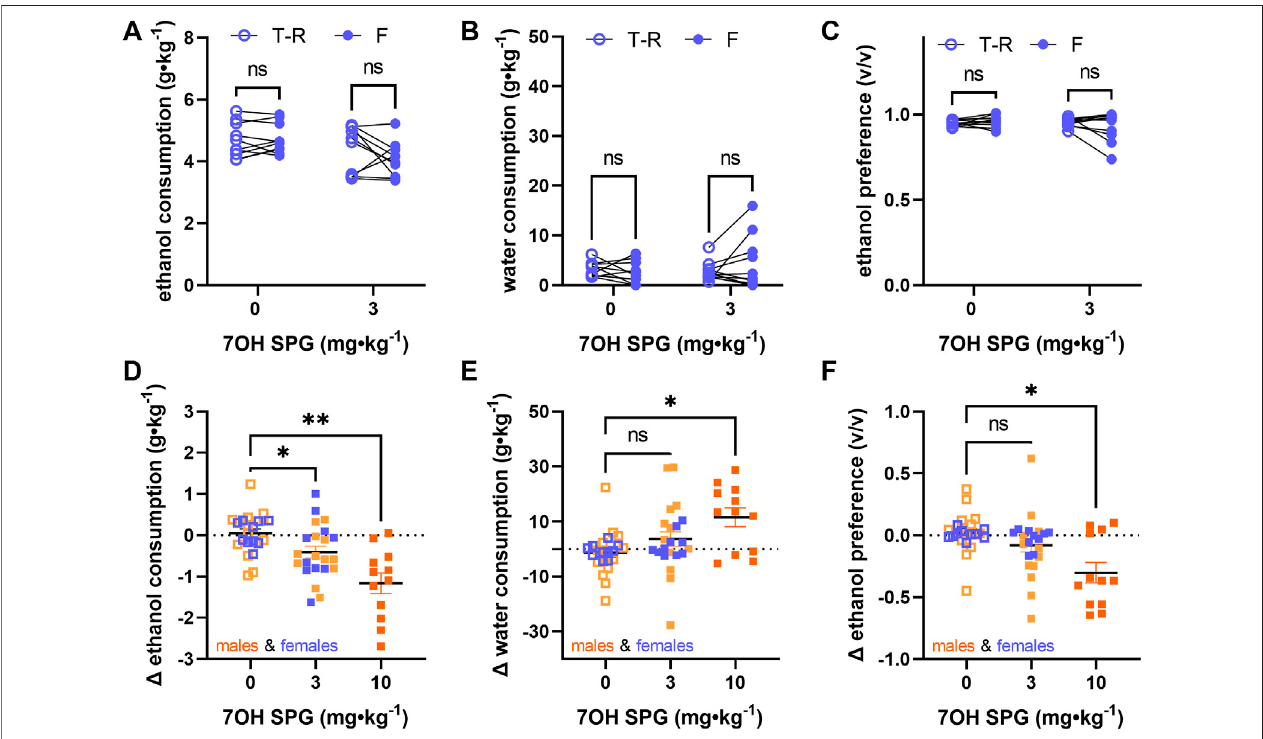
FIGURE 6 | Alcohol-modulating effects of 3 mg · kg ⁻ 1 7-hydroxyspeciogynine are not sex speci fi c. In WT female mice ( n (cid:2) 10), effects of 3 mg · kg ⁻ 1 7- hydroxyspeciogynine (s.c., 7OG SPG) on 10% ethanol consumption (A) , water consumption (B) , and ethanol preference (C) were evaluated in a voluntary two-bottle choice,limited access, drinking-in-the-dark paradigm. Male and female responses to7-hydroxyspeciogynine(3 and 10mg · kg ⁻ 1 ,s.c.) in thetwo-bottle choice paradigm were pooled and are shown as (D) change ( Δ ) in 10% ethanol consumption, (E) change ( Δ ) in water consumption, and (F) change ( Δ ) in ethanol preference. In panels (A – C) ,open circles are theaverage intake/preference on the preceding 3days (baseline), and closed circles are theintake on Fridays following drug exposure. In panel (D – F) , female and male mice are depicted with blue and orange symbols, respectively. * p < 0.05, ** p < 0.01 (for details, see Supplemental Tables S6 – S9 ).